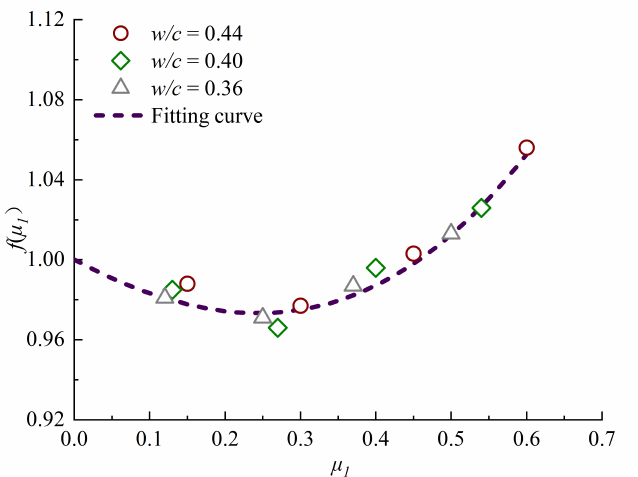
Figure 7. Stress function versus stress level µ 1